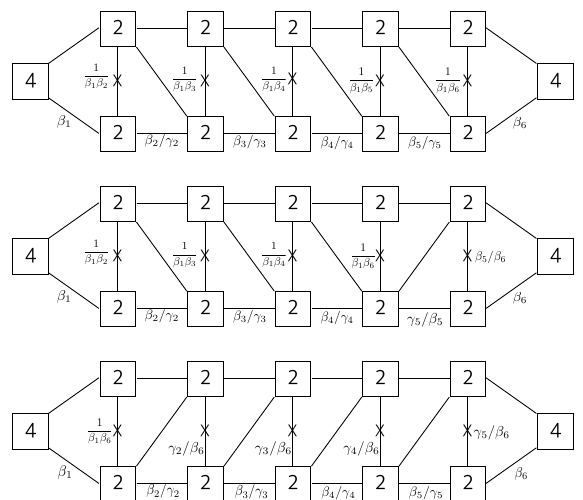
Figure 13 . Basic domain walls with the boundary conditions B 1 = f + 4 j + 4 j + 4 g and B 2 = f + 4 j + 3 ; (cid:0)j + 4 g and B 3 = f + 4 j + 4 j + 4 g , respectively, in the (cid:12)rst chamber. The (cid:12)rst and the third domain walls have the same boundary condition in the (cid:12)rst chamber, but they have di(cid:11)erent 4d chiral (cid:12)elds q i and